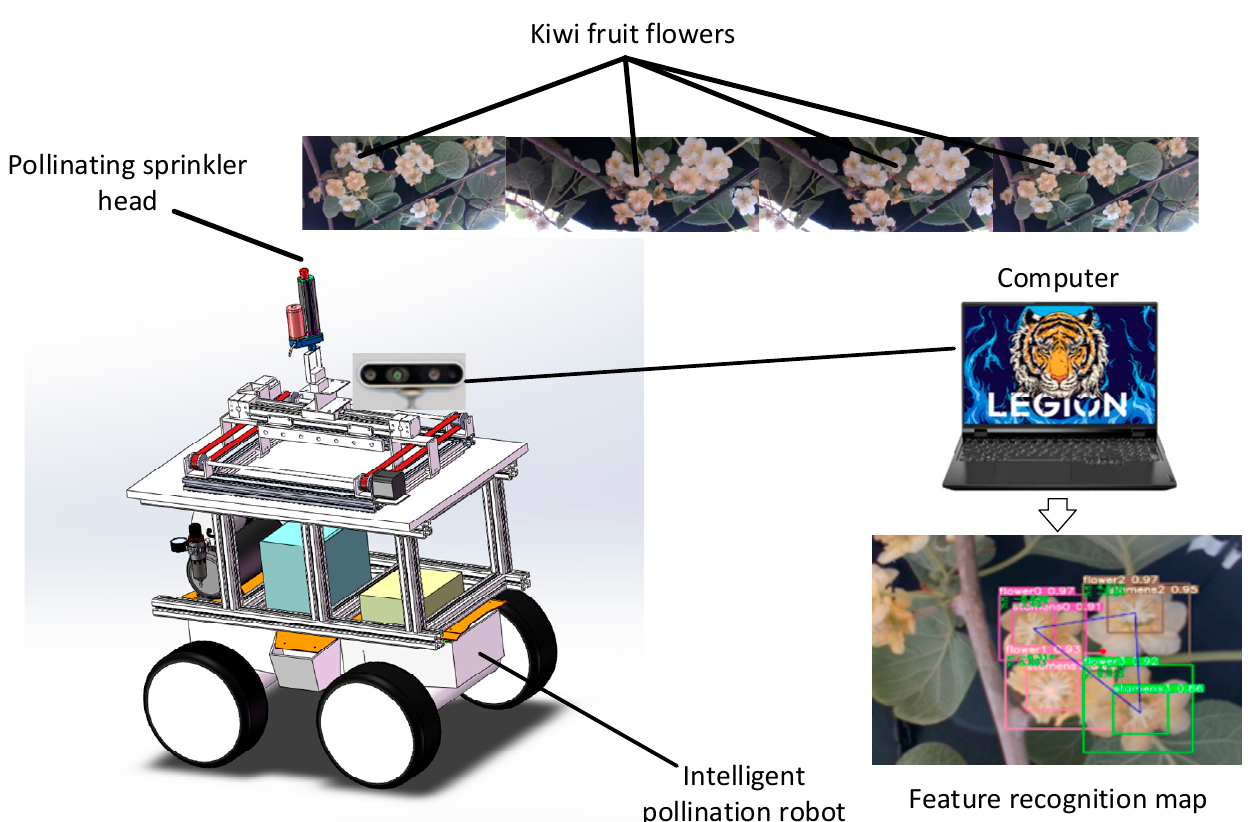
Figure 1. Kiwi fl ower feature recognition process. Figure 1. Kiwi flower feature recognition